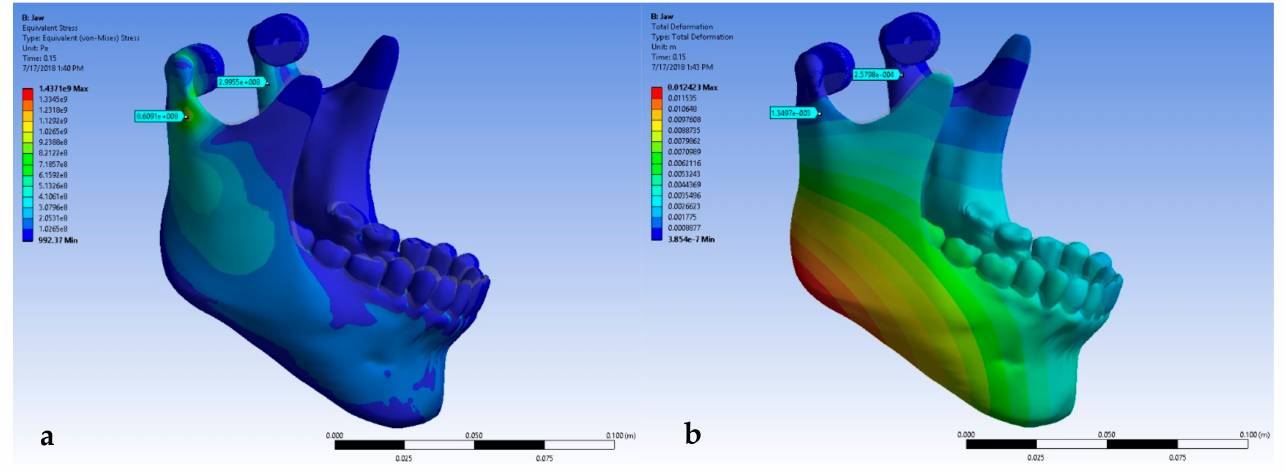
Figure 11. ( a ) Equivalent stress (unit: Pa) and ( b ) total deformation distributions (unit: m) on the mandible’s surface in the event of a lateral face impact and complete edentation: equivalent (von Mises stress) stress, time: 0.15